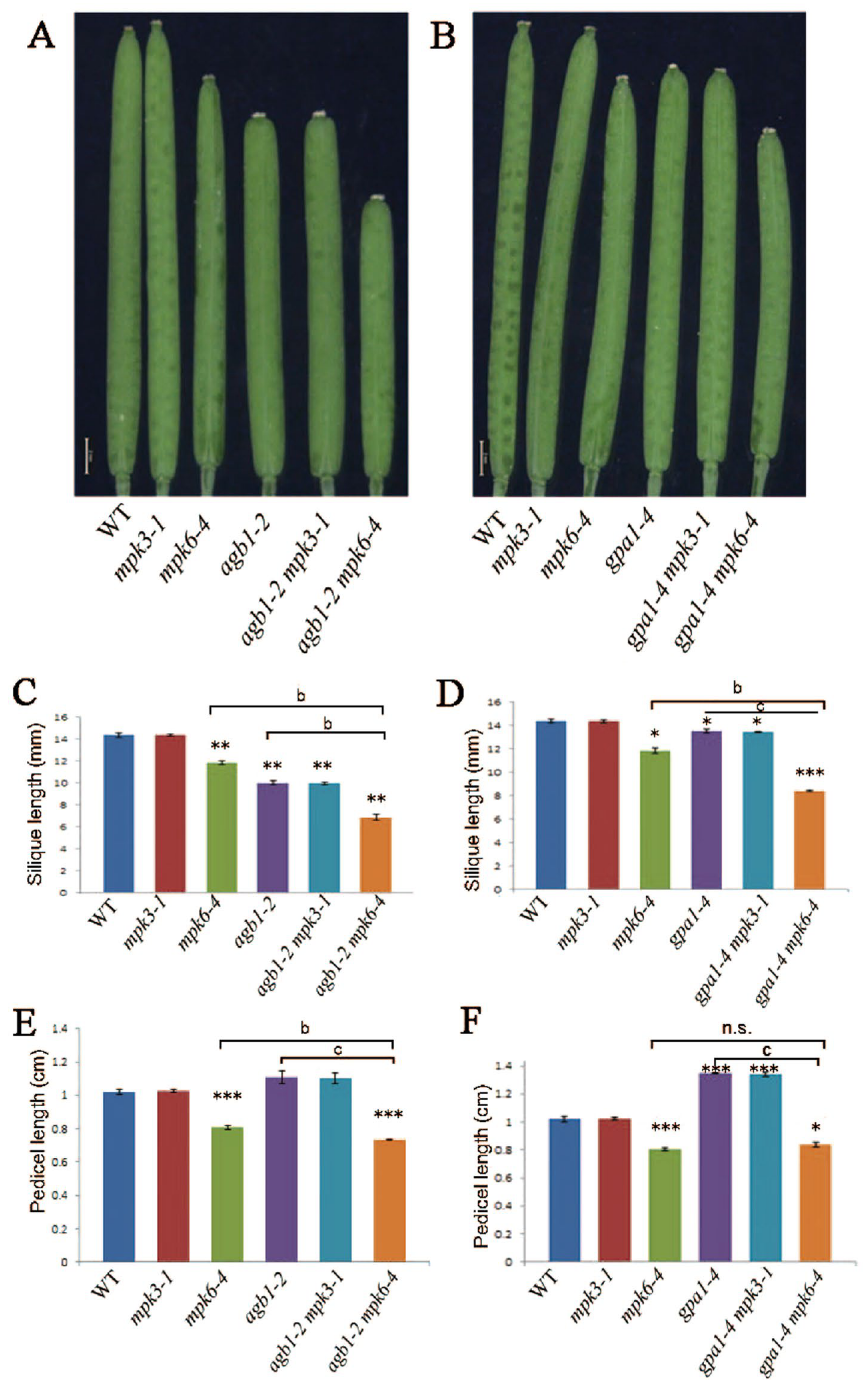
Figure 6. Length of siliques and pedicels of agb1 , gpa1 , mpk3 and mpk6 . ( A ) Siliques of wild-type plants (Col-0), mpk3-1 , mpk6-4, agb1-2 and double mutant agb1-2 mpk3-1 , agb1-2 mpk6-4 . ( B ) Siliques of wild- type plants (Col-0), mpk3-1 , mpk6-4, gpa1-4 and double mutant gpa1-4 mpk3-1 , gpa1-4 mpk6-4 . Bar, 1 mm. ( C and D ) Statistics of silique length of wild-type plants (Col-0), mpk3-1 , mpk6-4 , agb1-2 , gpa1-4 and double mutant agb1-2 mpk3-1 , agb1-2 mpk6-4 , gpa1-4 mpk3-1 , gpa1-4 mpk6-4 . ( E and F ) Statistics of pedicel length of genotype mentioned above. Averages ( ± SE, n ≥ 30 per genotype) were determined in three independent experiments. Different letters indicate significantly different values (b, p < 0.01; c, p < 0.001; ANOVA, Tukey test). Asterisks indicate a significant difference between a given genotype and the wild type ( * p < 0.05, ** p < 0.01, *** p < 0.001, Student’s t test). n.s. no